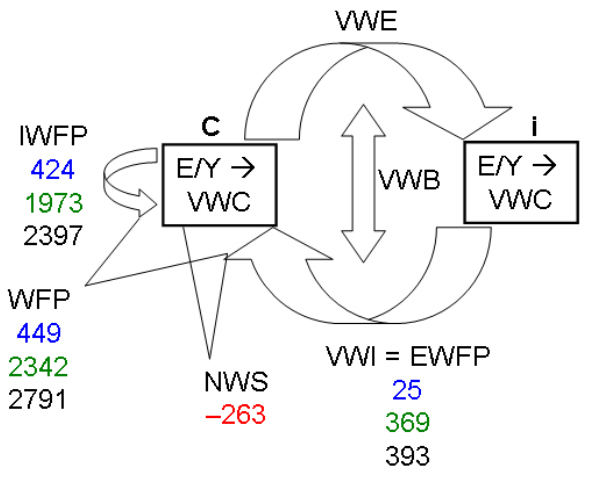
Fig. 1. Overview of the water flows illustrated for countries C and i (see Methods) and total global values of blue (in blue), green (in green) and total (in black) water footprints as well as net water savings (in red). All values are in km 3 and represent sums over the 11 CFTs included in this study averaged for the period 1998– 2002. Note that the global VWE equals the global VWI, and that the global VWB is zero. Global water and land productivity are im- plicitly increased through trade by 8% and 5%, respectively (see